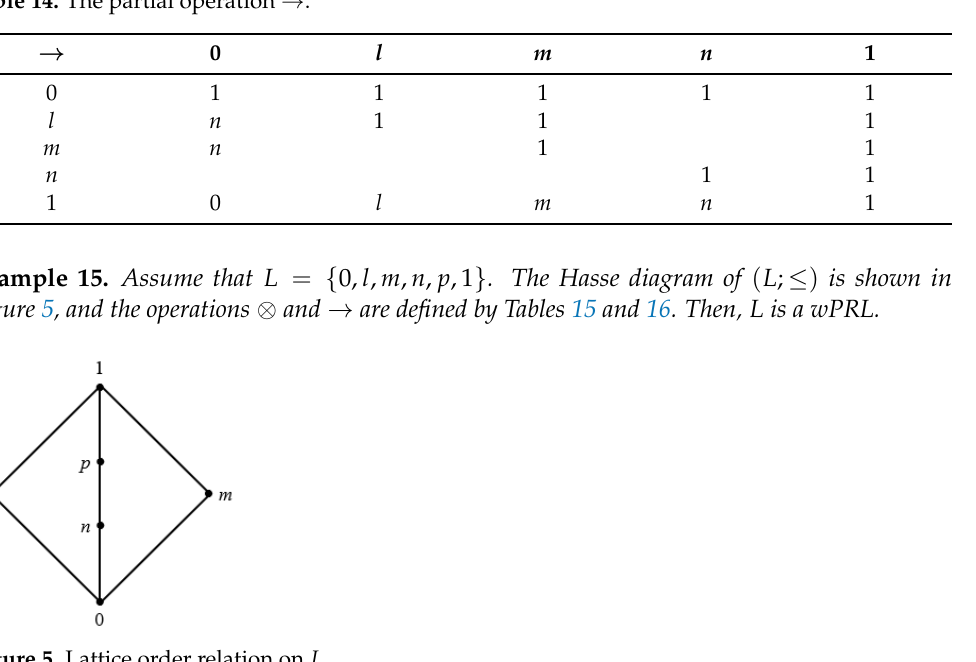
Figure 5. Lattice order relation on L . Table 15. The partial operation ⊗ .